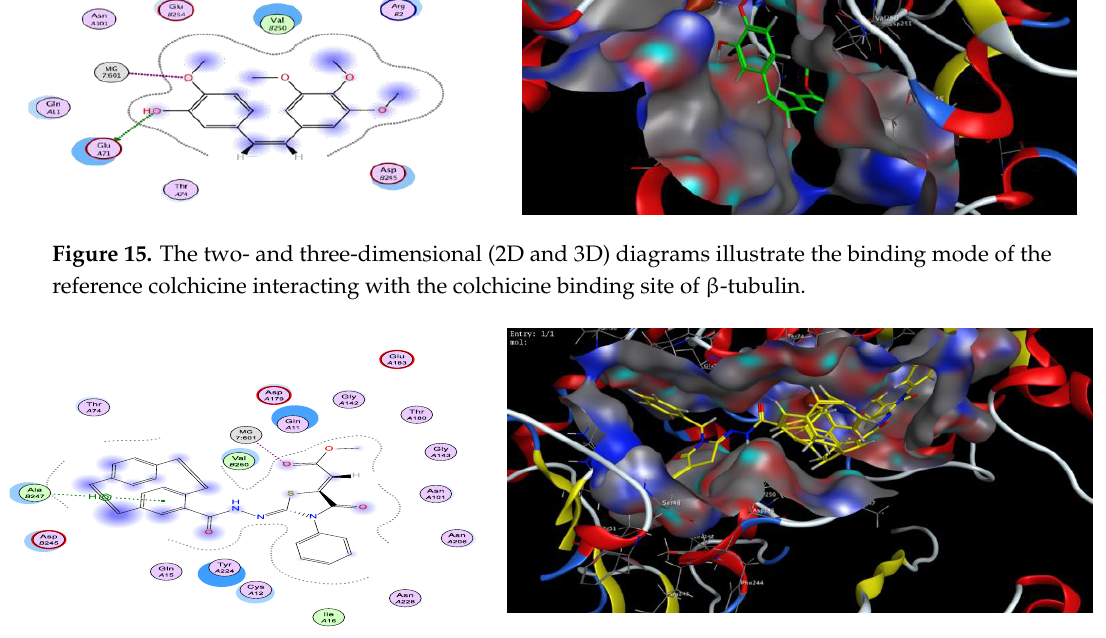
Figure 16. The 2D and 3D diagrams illustrate the binding mode of 3a interacting with the colchicine binding site of β-tubulin.